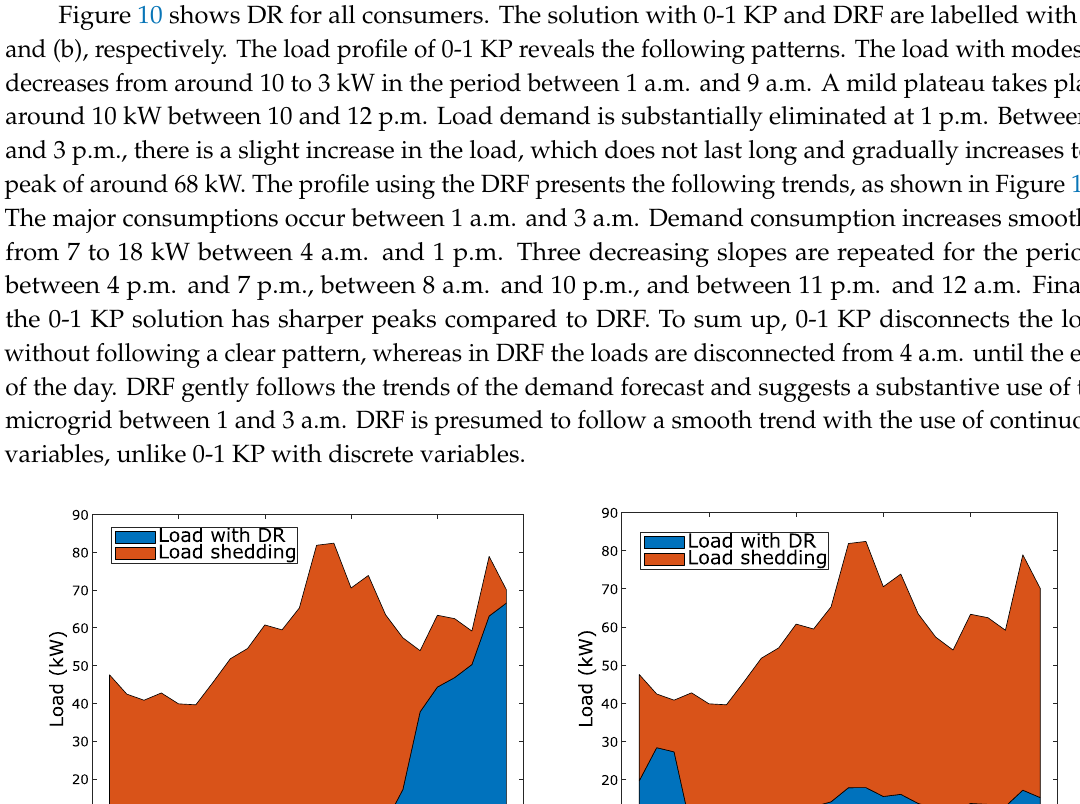
Figure 9. Load profile with DR: ( a ) 0-1 knapsack problem; ( b ) demand response function.